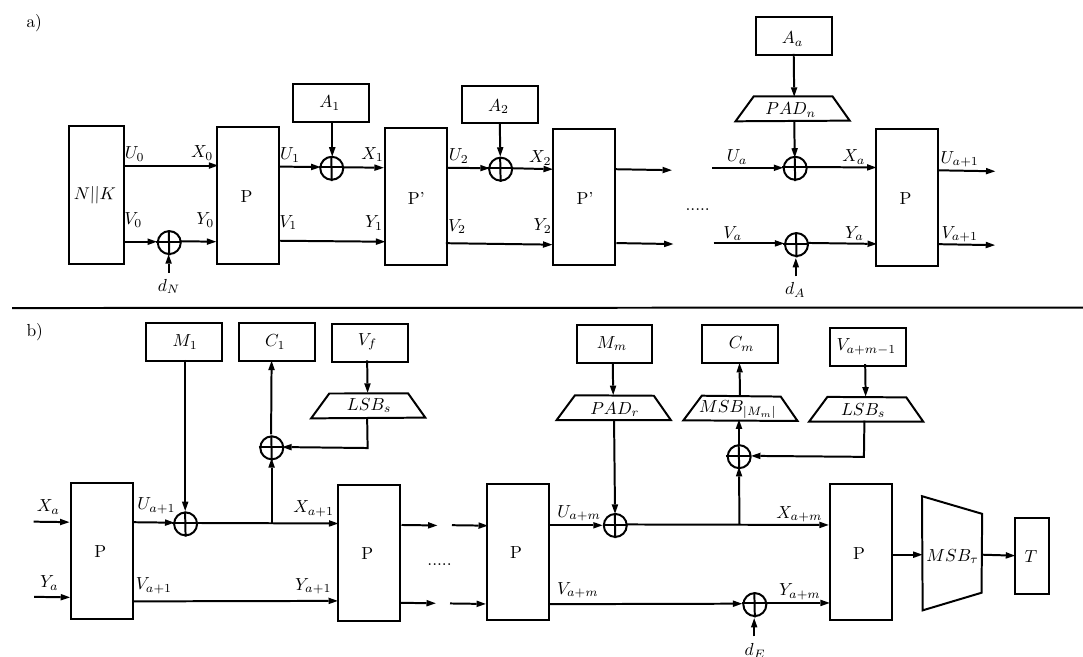
Figure 11. Encryption version of Oribatida AEAD Algorithm, where ( a ) is the nonce/AD stage and ( b ) is the encryption stage (scheme based on the one found in